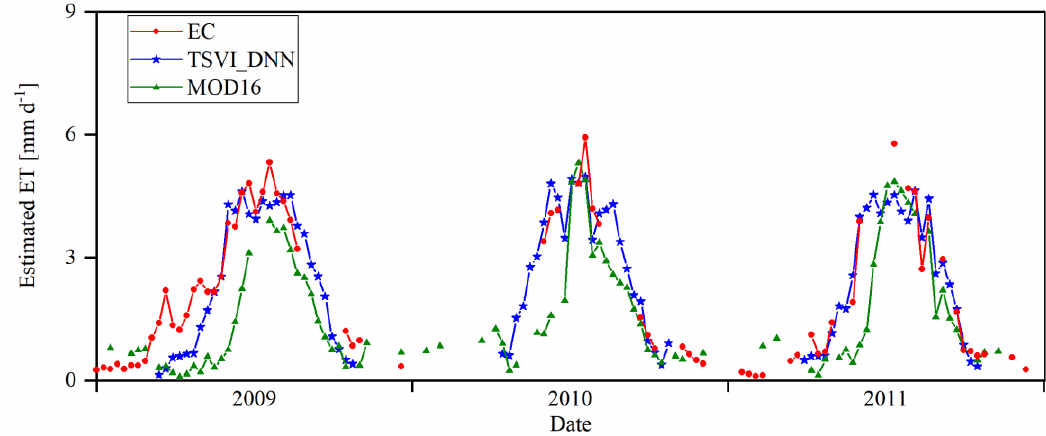
Figure 8. Time series of ET estimates from the TSVI_DNN model and the MOD16 ET product, as compared to in situ measurements at the YK station during 2009-2011. Table 2. Error metrics of ET estimates from the TSVI_DNN model and MOD16 ET product as compared to in situ measurements at the YK station during 2009-2011, including R (correlation coefficient), RMSE (root mean square error, mm d −1 ), bias (mean bias, mm d −1 ), MAD (Mean Absolute Deviation, mm d −1 ), and N (the number of samples). Product